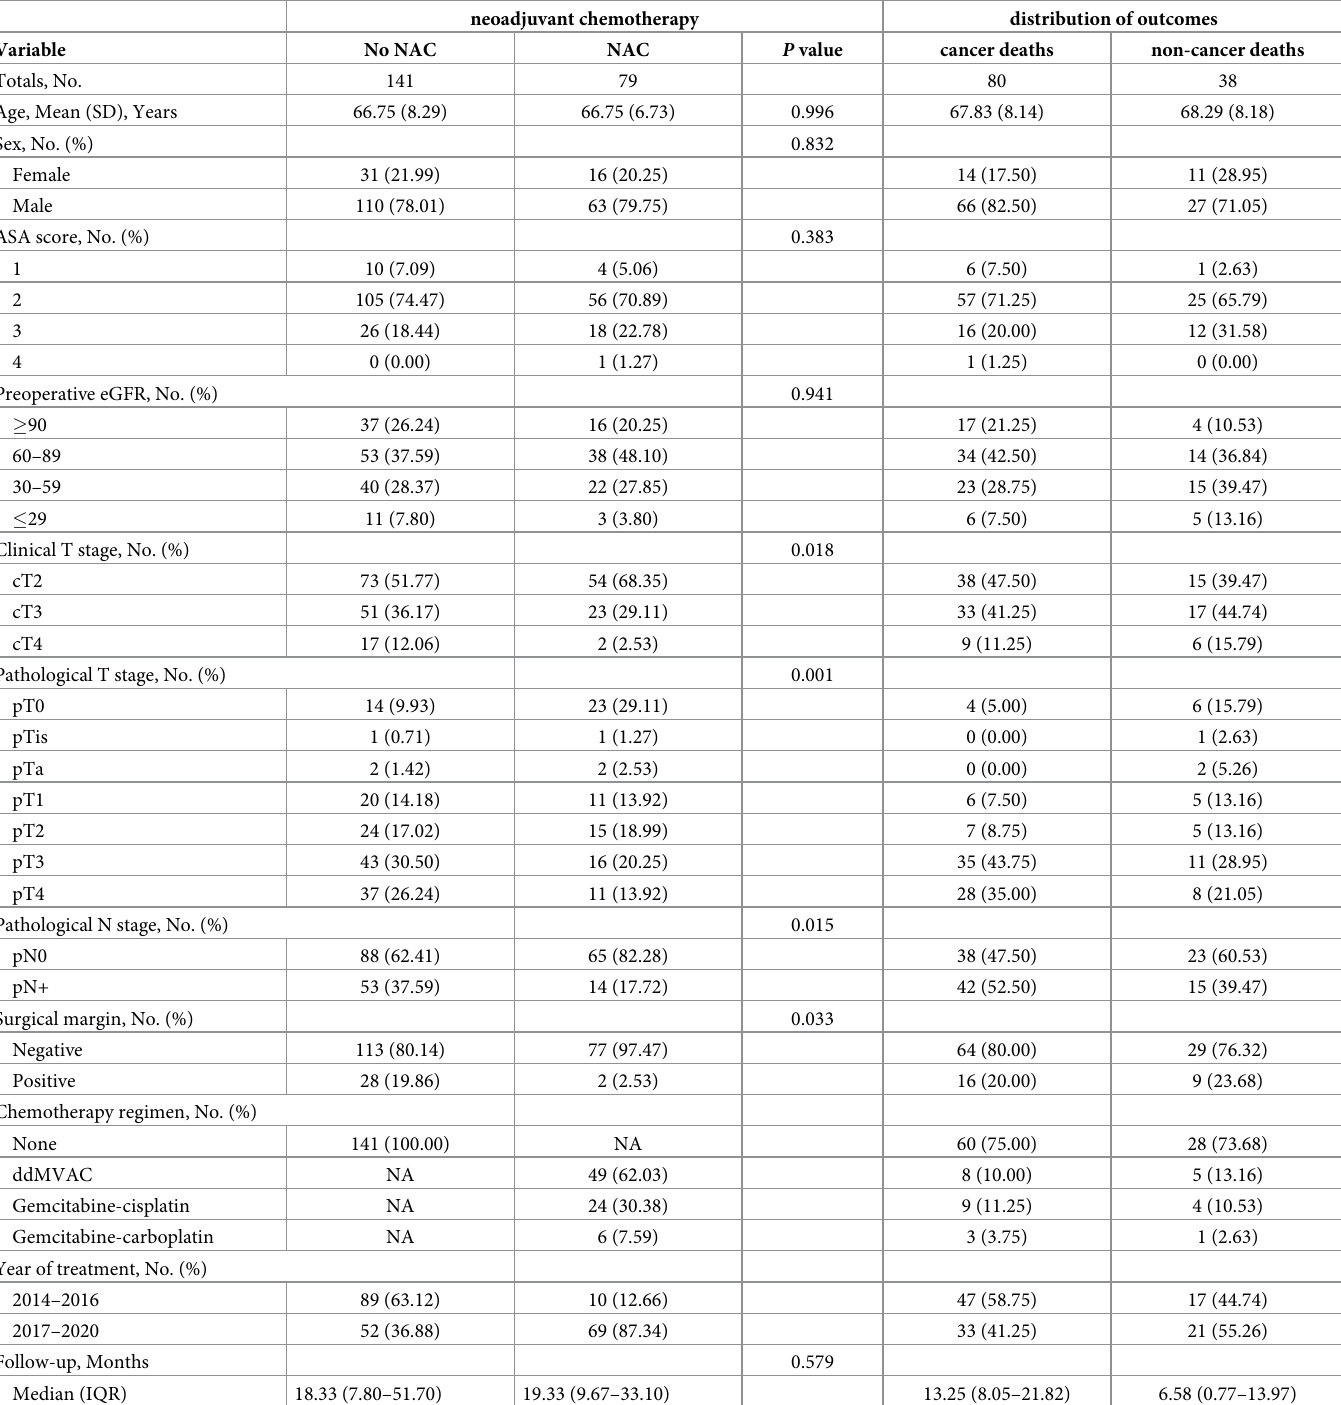
Table 1. Baseline patients’ characteristics and distribution of